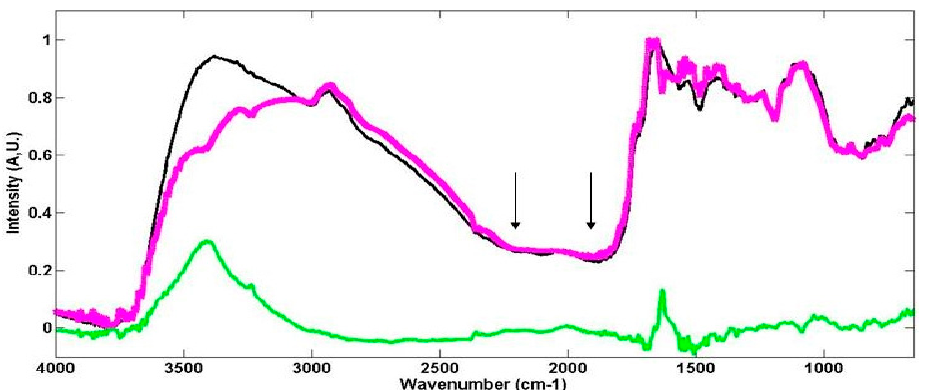
Figure 1. Example of control (black), exposed (purple), and difference (green) FTIR spectra of Vicia faba samples treated with 30 g L − 1 As. The negative values observed for the difference spectrum in the range between 3100 and 1400 cm − 1 show a reduction of the molecular absorptions in the exposed samples with respect to the control sample. The two black arrows show the range where a flat water band could be observed in the case of a non-efficient lyophilisation.